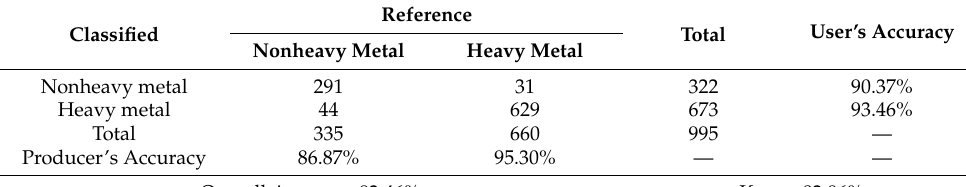
Figure 8. Classification accuracy in 2019. Table 3. Classification accuracy evaluation in 2020.